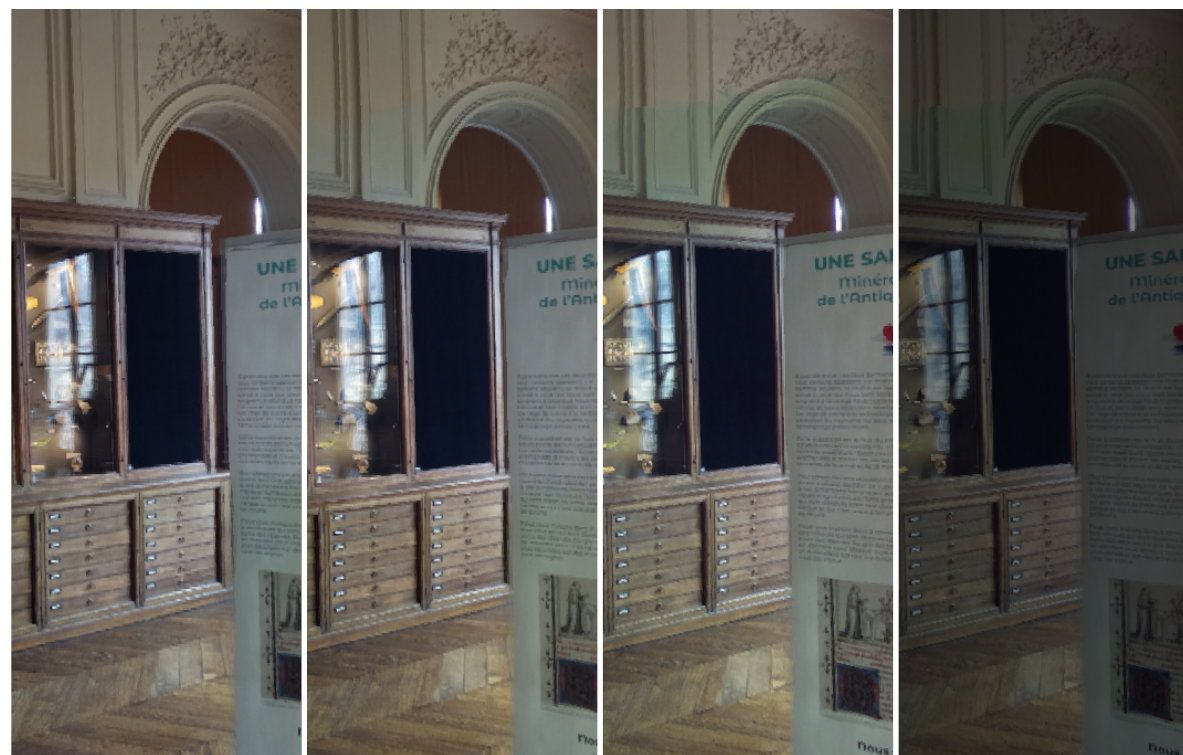
Figure 6. User’s view in the “Museum” scene rendered with view-dependent effects and a view radius of 20 cm. From left to right, the user’s head has moved to x = 0 cm, x = 10 cm, x = 20 cm, and x = 22.5 cm. Notice how the view fades out (at x = 25 cm, it would be entirely black), as well as how the reflection on the window moves in front of the items inside the glass